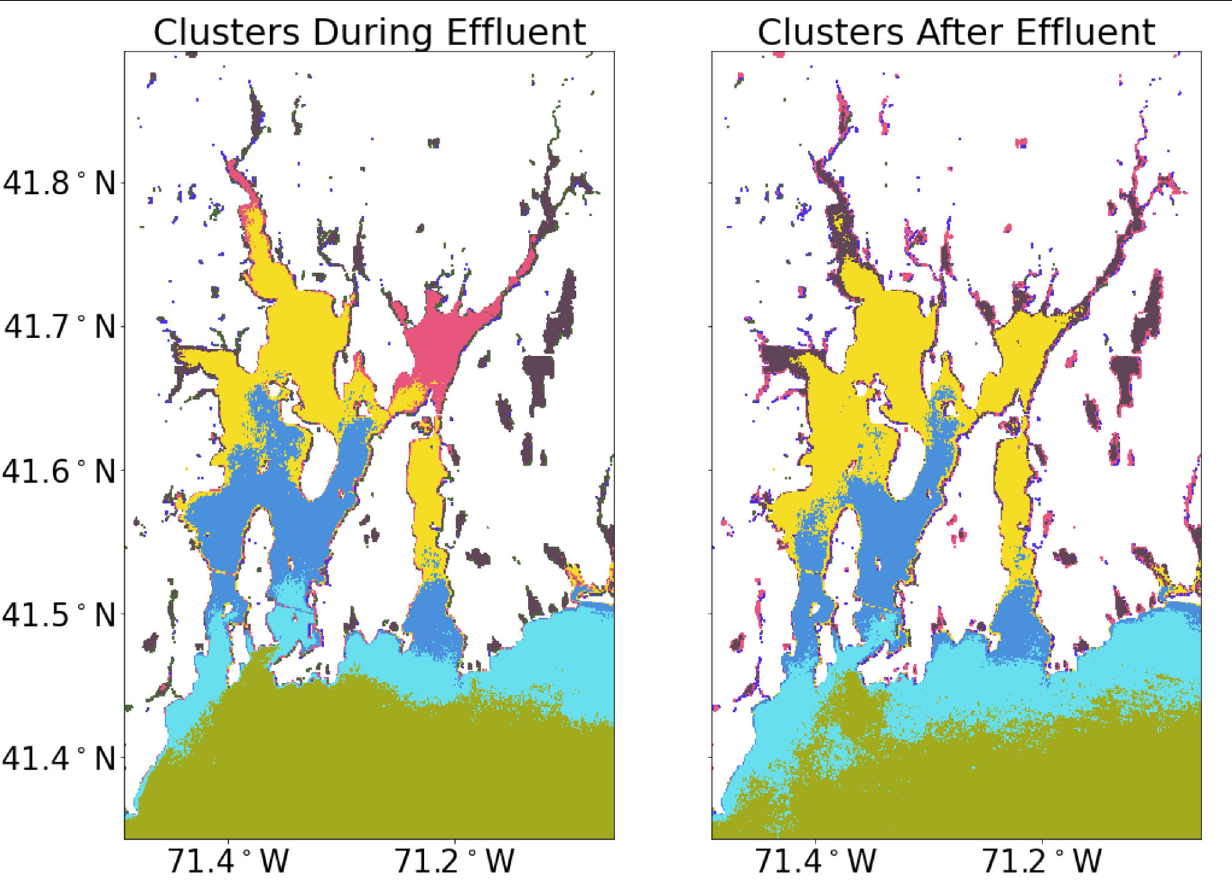
no thermal plume in data taken after 2011. To quantify the amount of cooling for Brayton Point and Mt. Hope Bay, the mean temperature anomalies from the 2013 to 2020 period are subtracted from the 2003-2010 period, representing lower emissions, as well as from the 1993 to 2000 period, representing high emissions. Uncertainty in this metric was determined by using bootstrapping and taking the standard deviation of the resampled means. Immediate cooling in Mt. Hope Bay at the time